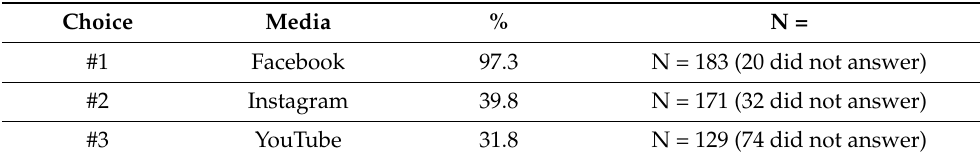
Table 2. The most frequently-used digital and social media by younger men.